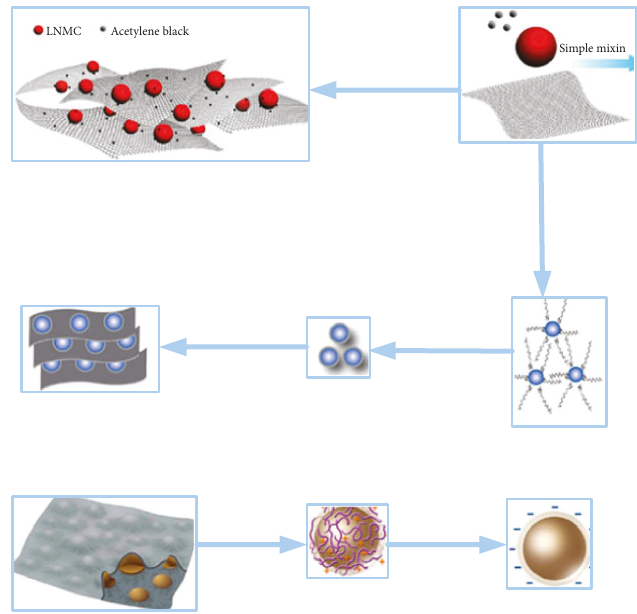
Figure 2: Compound